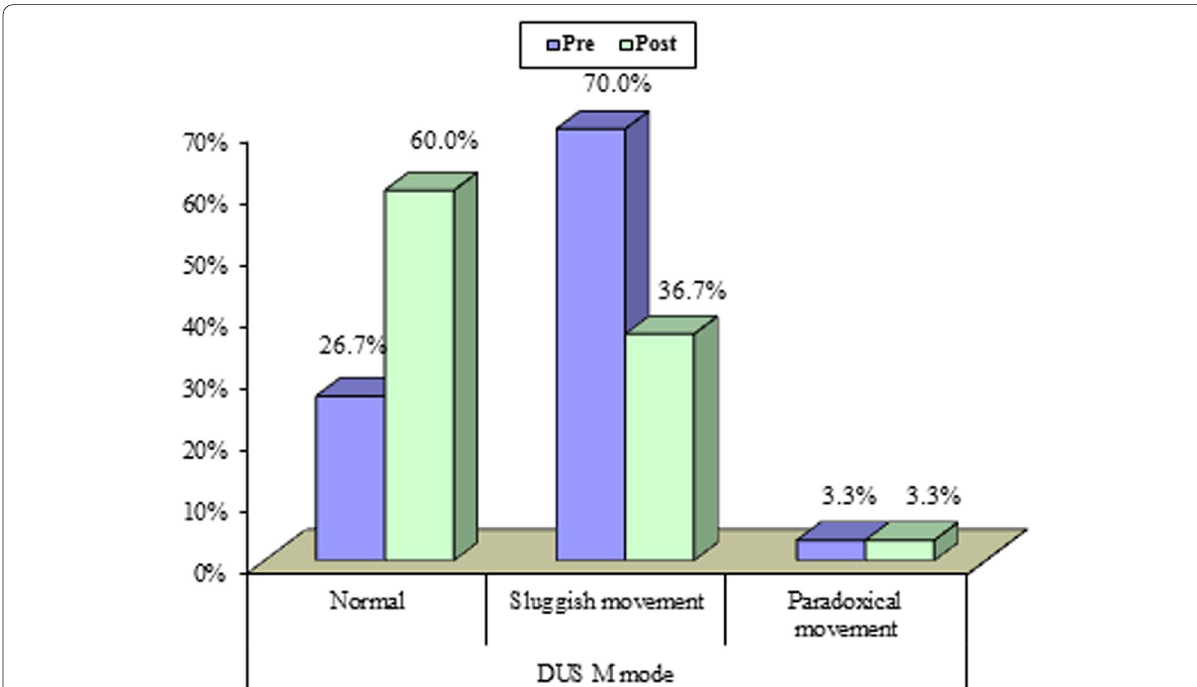
Fig. 3 Diaphragmatic ultrasound in patients with pleural effusion showed improvement in shape and movement after therapeutic